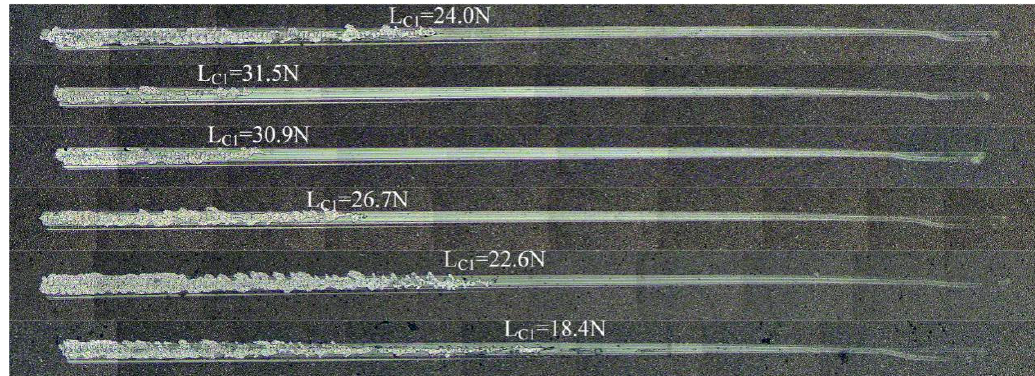
Figure 4. The scratch morphology of DLC films.